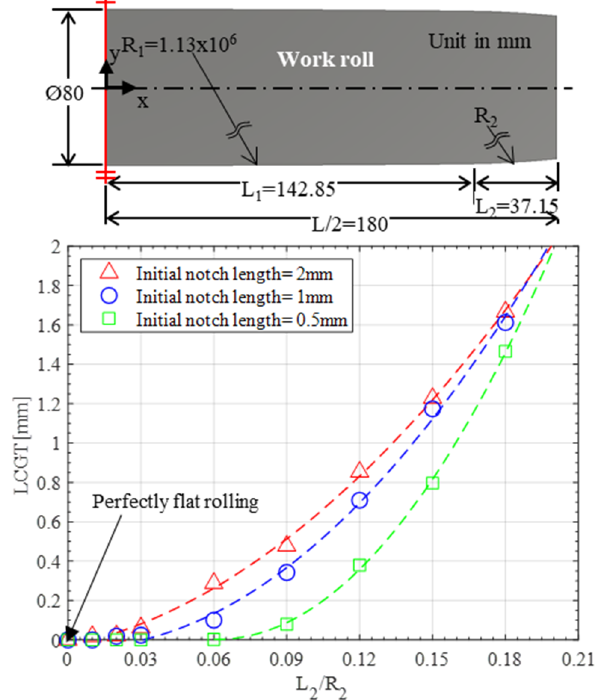
Figure 11. Length of crack grown in the transverse (LCGT) direction with the variation of the secondary barrel length (L 2 ) to the secondary radius of curvature of the work roll surface profile (R 2